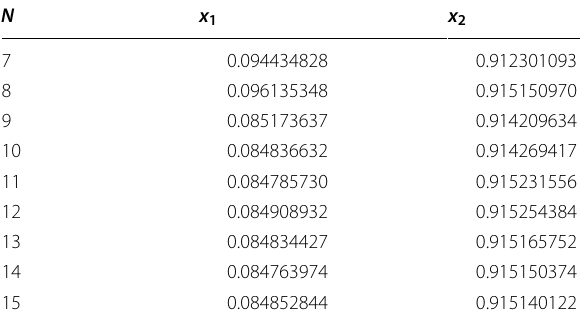
Table 13 Lift-off points x 1 and x 2 at q = q 5 for various N